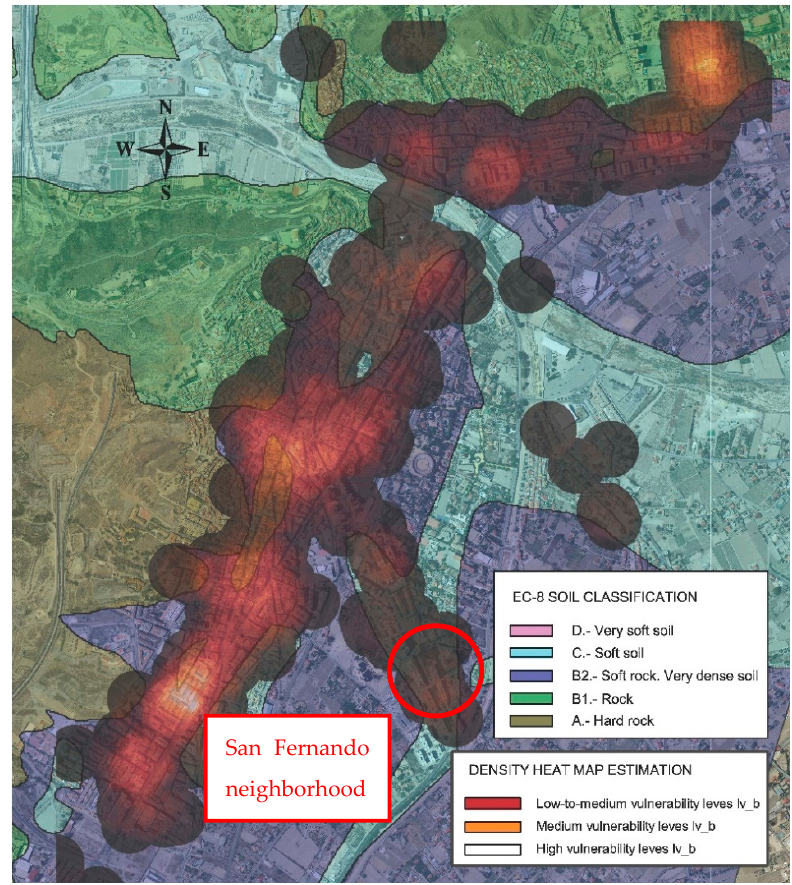
Figure 8. GIS plotting of density estimation for the vulnerability indexes Iv b of RC buildings analyzed in Lorca, obtained according to the proposed LM1 method, overlapped with the EC-8 soil types identified in the microzonation study of Lorca. The location of the San Fernando neighborhood is highlighted.